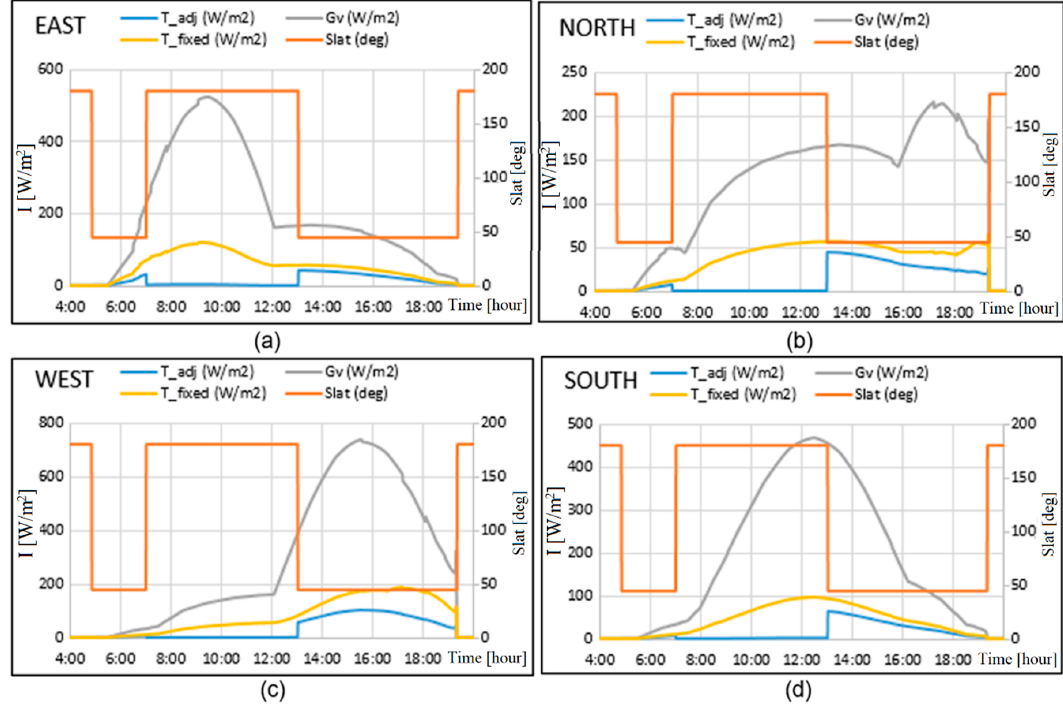
Figure 6. Irradiance and Slat angle in summer day for different exposure: ( a ) East ( b ) North ( c ) West ( d ) South.